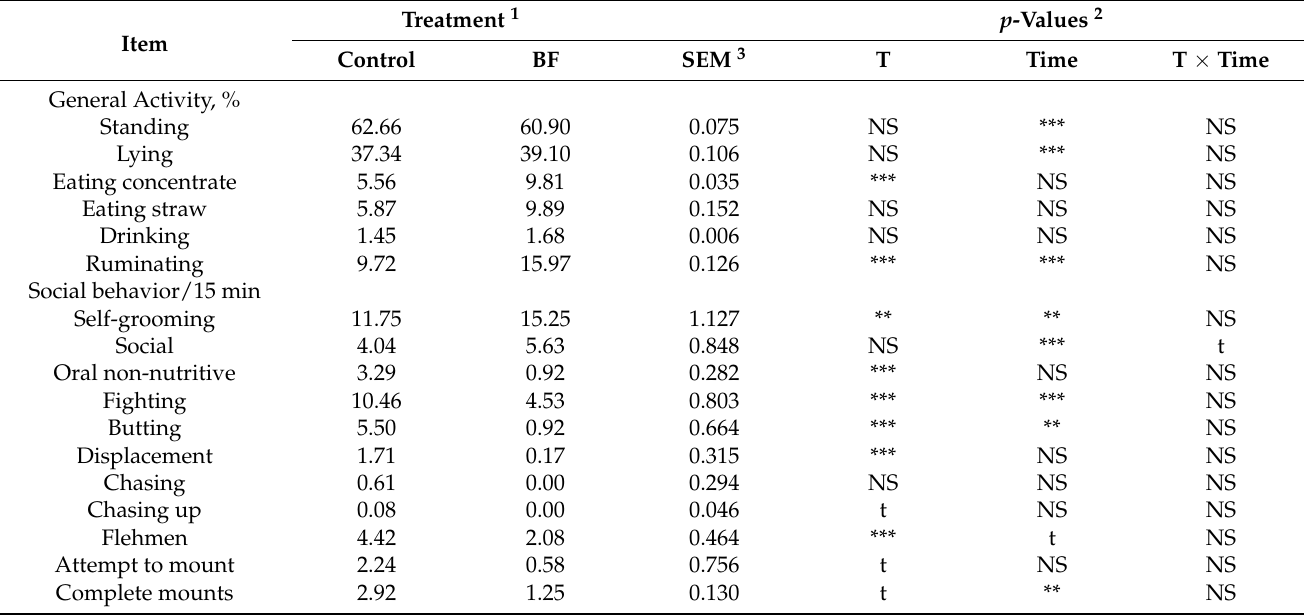
Table 5. General activities (%) and social behavior (times/15 min) for finishing phase in Holstein bulls fed high-concentrate diets supplemented with citrus